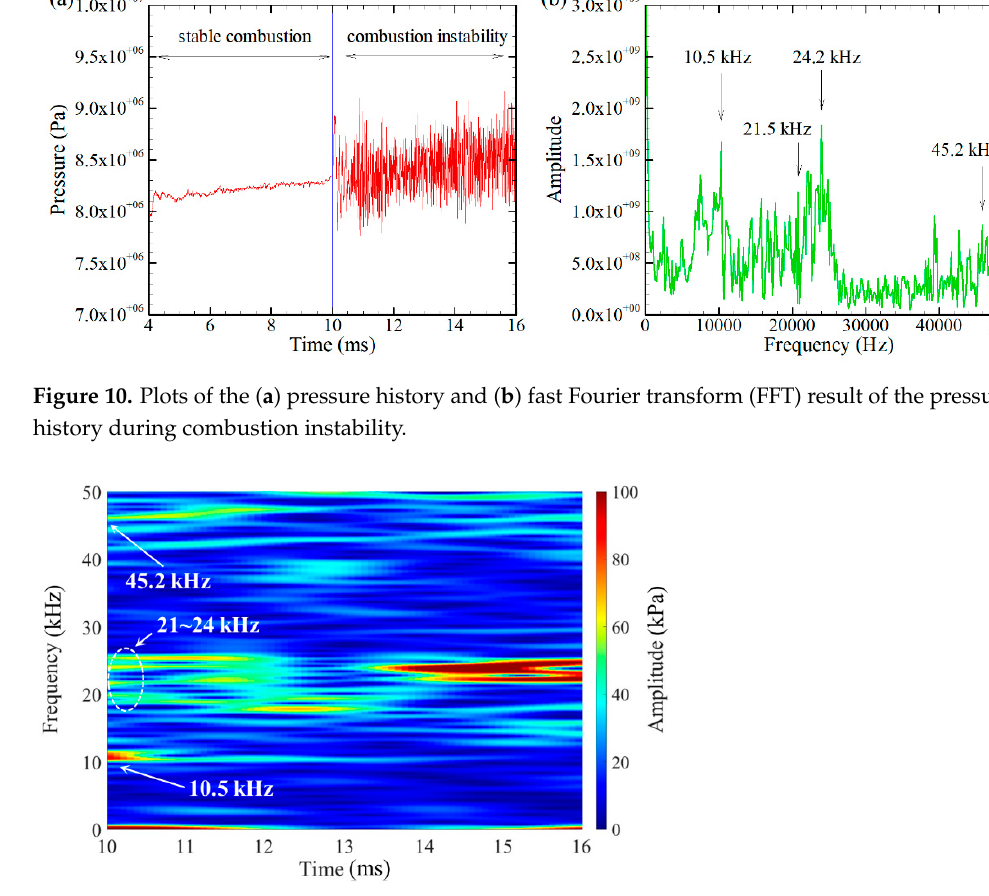
Figure 11. The short-time Fourier transform (STFT) result during combustion